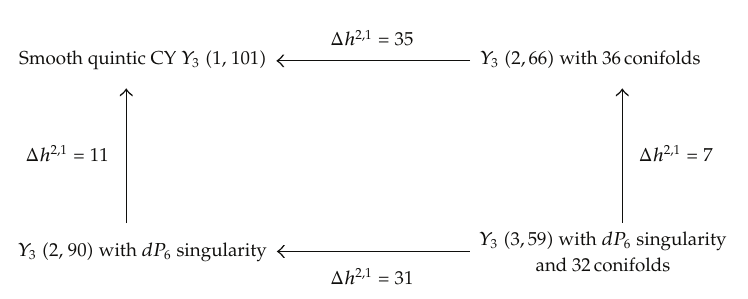
Figure 1: Possible geometric transitions of quintic CY. The numbers in parentheses denote the dimensions (cid:6) h 1 , 1 ,h 2 , 1 (cid:7) .